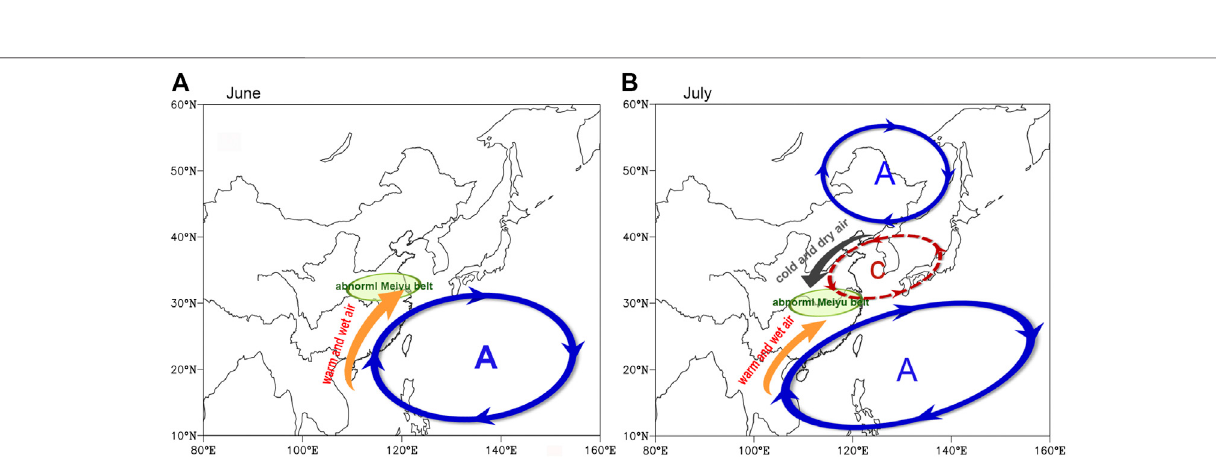
Frontiers in Earth Science |